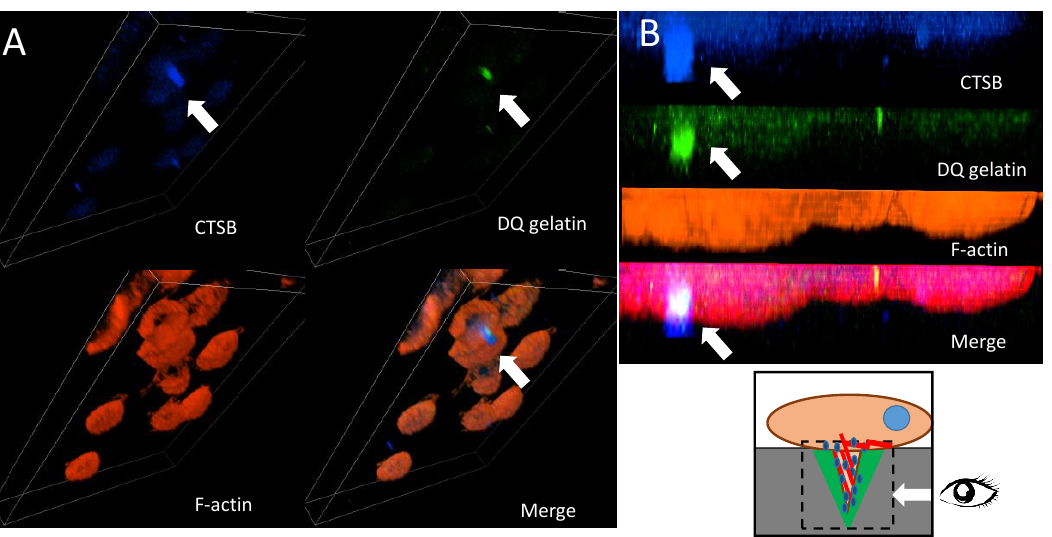
Figure 5. Cellular localization of cathepsin B in HT-29 cells with Snail overexpression. ( A ) 3D Z stack of HT-29 cells overexpressing Snail. Cathepsin B was visualized by confocal microscopy. Arrows indicate accumulation of cathepsin B (blue) in the cylindrical invadosome structures on ventral side of the cells visualized as F-actin staining (red), ECM degradation was visualized by fluorescence from digested DQ-gelatine (green). ( B ) Zoom of YZ axis. Arrows point co-localization of cathepsin B and digested gelatine in invadosomes.